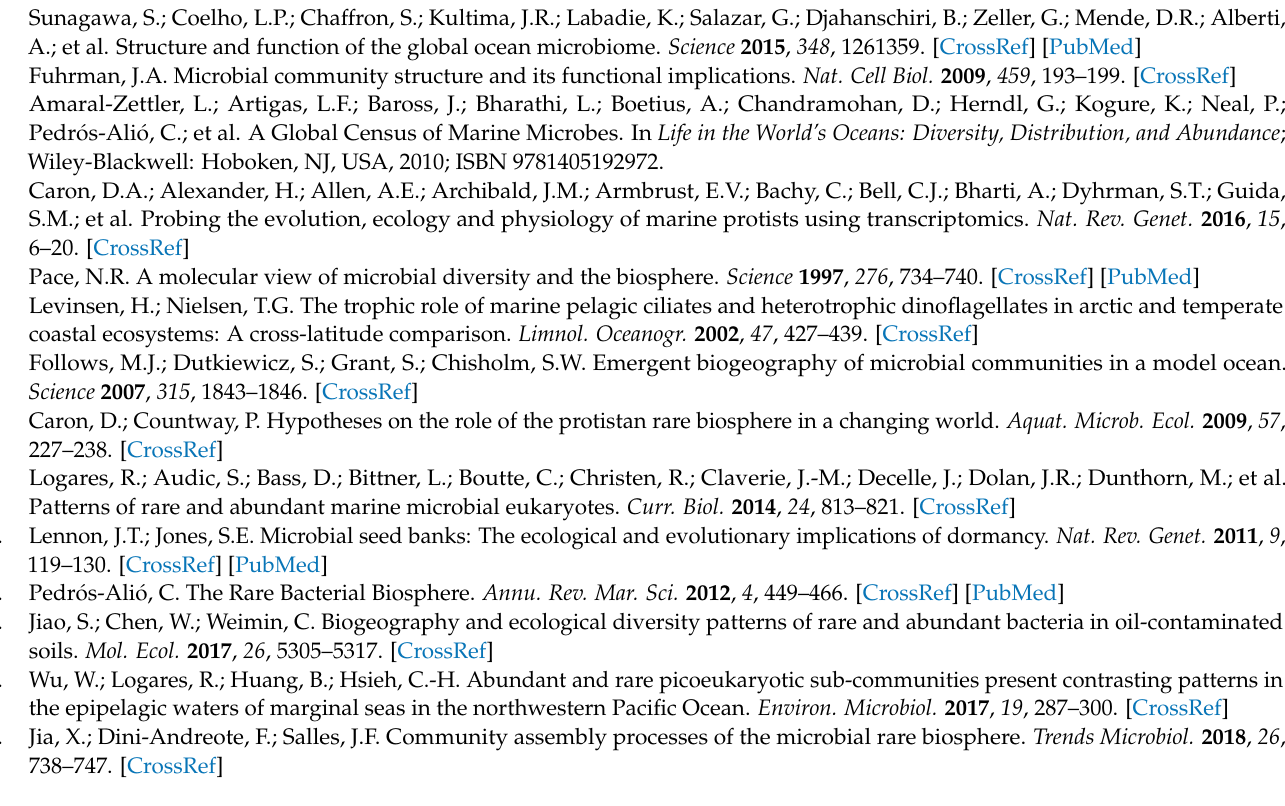
and Picozoa, Figure S5: Alpha diversity estimates of OTU richness (A) and Shannon (B) the four groups (surface, CS, DCM, and Deep). ** p < 0.01, * p < 0.05, Figure S6: Sequences abundance of the abundant (A) and OTU richness of the rare (B) groups at the supergroup taxonomic level, Figure S7: Compositions of the rare taxa that can shift to abundant taxa in the four groups, Table S1: Name, coordinates, and environmental parameters of the samples. HP: Heterotrophic prokaryotes; PPEs, pigmented pico-sized eukaryotes; VLPs, viral like particles; ND: Not detected; BDL: Below detection limit, Table S2: List of the twelve abundant OTUs with the relative abundance of sequences, taxonomic identification, GenBank accession number and the identification of the nearest named neighbor (NNN), similarity (%-S) with the NNN, and GenBank accession number of the nearest neighbor (NN) and similarity (%-S) with